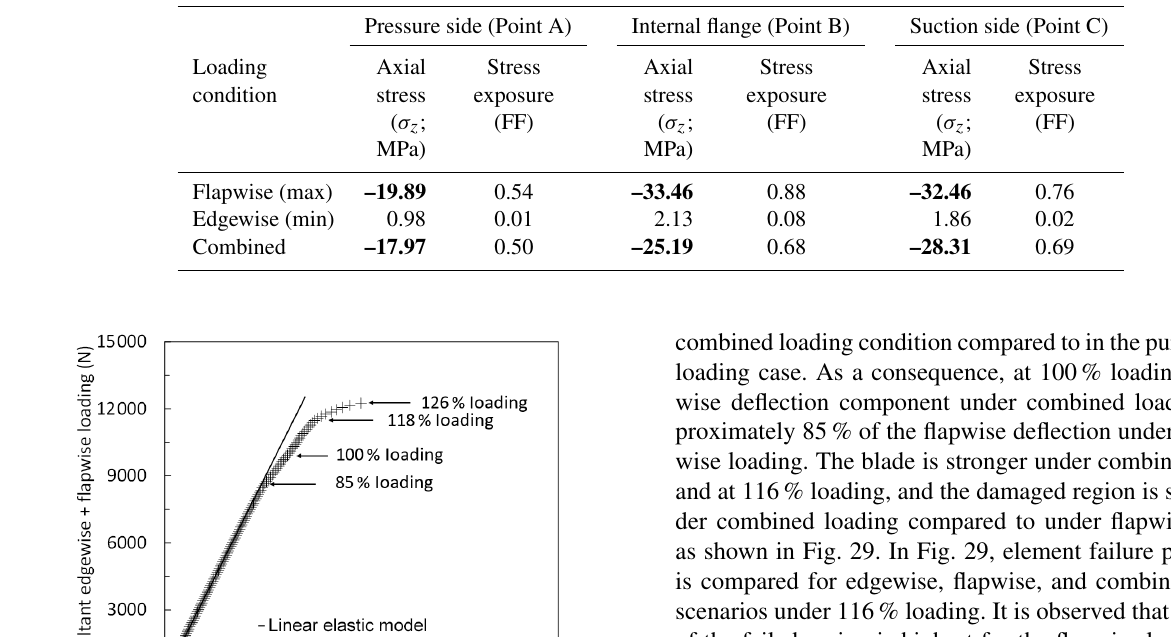
Table 3. Axial stress levels and stress exposures in the critical regions of blade under flapwise, edgewise and combined (flapwise plus edgewise) loading in 100% extreme loading cases. Compressive stress components are denoted in bold.